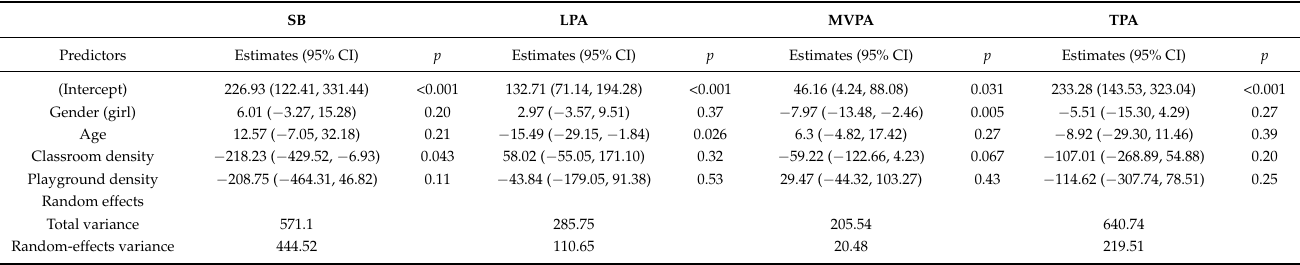
Table 2. Mixed-model regressions for the association between explanatory variables and objective measures of physical